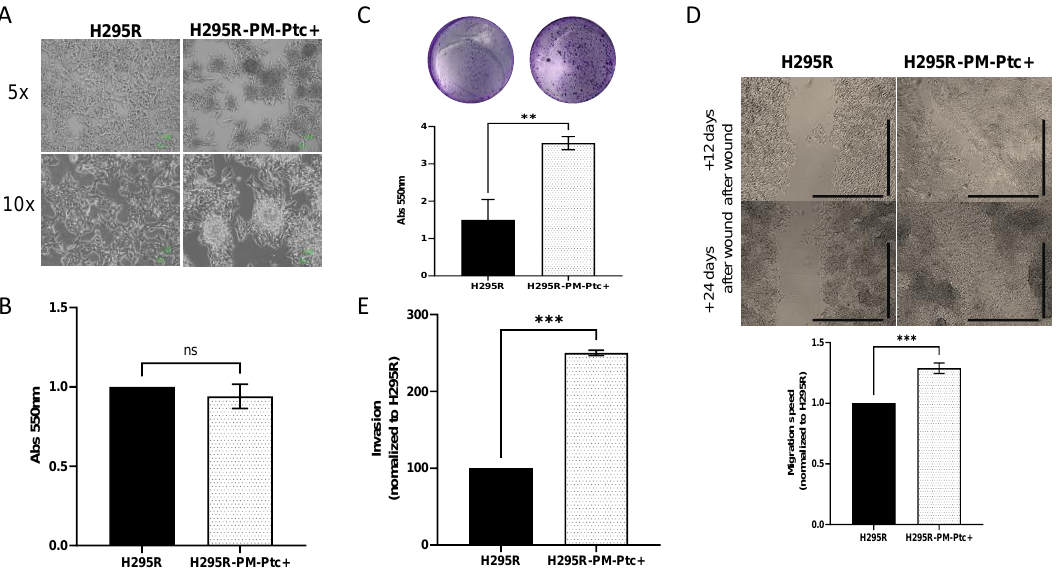
Figure 3. H295R PM-Ptc+ cells are more aggressive than parental H295R cells . ( A ) H295R-PM-Ptc+ cells present a different growth pattern. ( B ) H295R-PM-Ptc+ show non-significant lower proliferative properties as H295R cells over 72 h ( n = 3; no significant difference (n.s.)). ( C ) H295R-PM-Ptc+ cells form more clones than ACC cells 14 days after seeding 5000 cells/well. Histogram represents the quantification of clones formed using crystal violet for 3 independent experiments ( p = 0.003). A representative image of clones stained with crystal violet is provided for each cell group. ( D ) H295R- PM-Ptc+ cells migrate faster than H295R cells. Migration ability of the two cell groups was evaluated using wound healing experiment. Slope of migration for 24 h, normalized to H295R, n = 5, ( p = 0.005). H295R-PM-Ptc+ cells completely reclose the wound compared to H295R cells, images taken 12 and 20 days after producing the wound (5× objective, scale = 100 µm). ( E ) H295R-PM-Ptc+ cells are more invasive than parental cells. More H295R-PM-Ptc+ cells were able to pass through Matrigel-coated filters compared to H295R. Invasion was normalized to H295R and proliferation differences, cells passed through the filter were counted and reported to the total cell number ( n = 2). All data presented are the mean ± SEM of independent experiments. **: p -value < 0.005, ***: p -value < 0.0005.